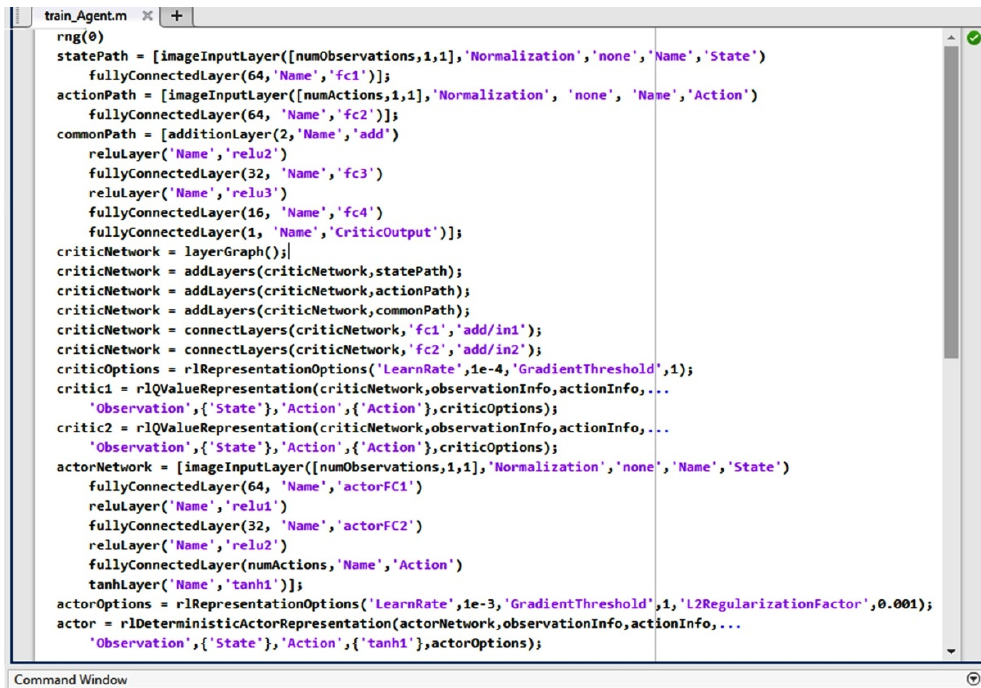
Figure 6. An example of the MATLAB syntax program code for the DNN creation.